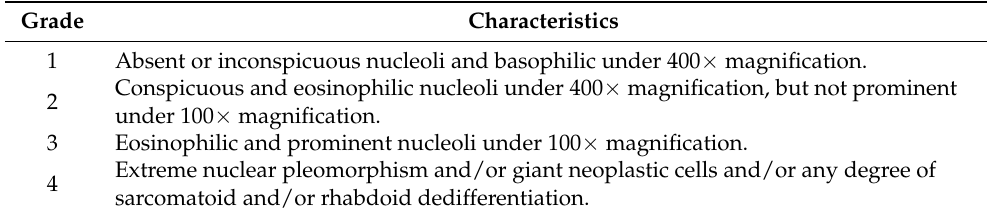
Table 1. Modified ISUP/WHO Fuhrman nuclear grading system adapted from Moch et al. [4]. Grade